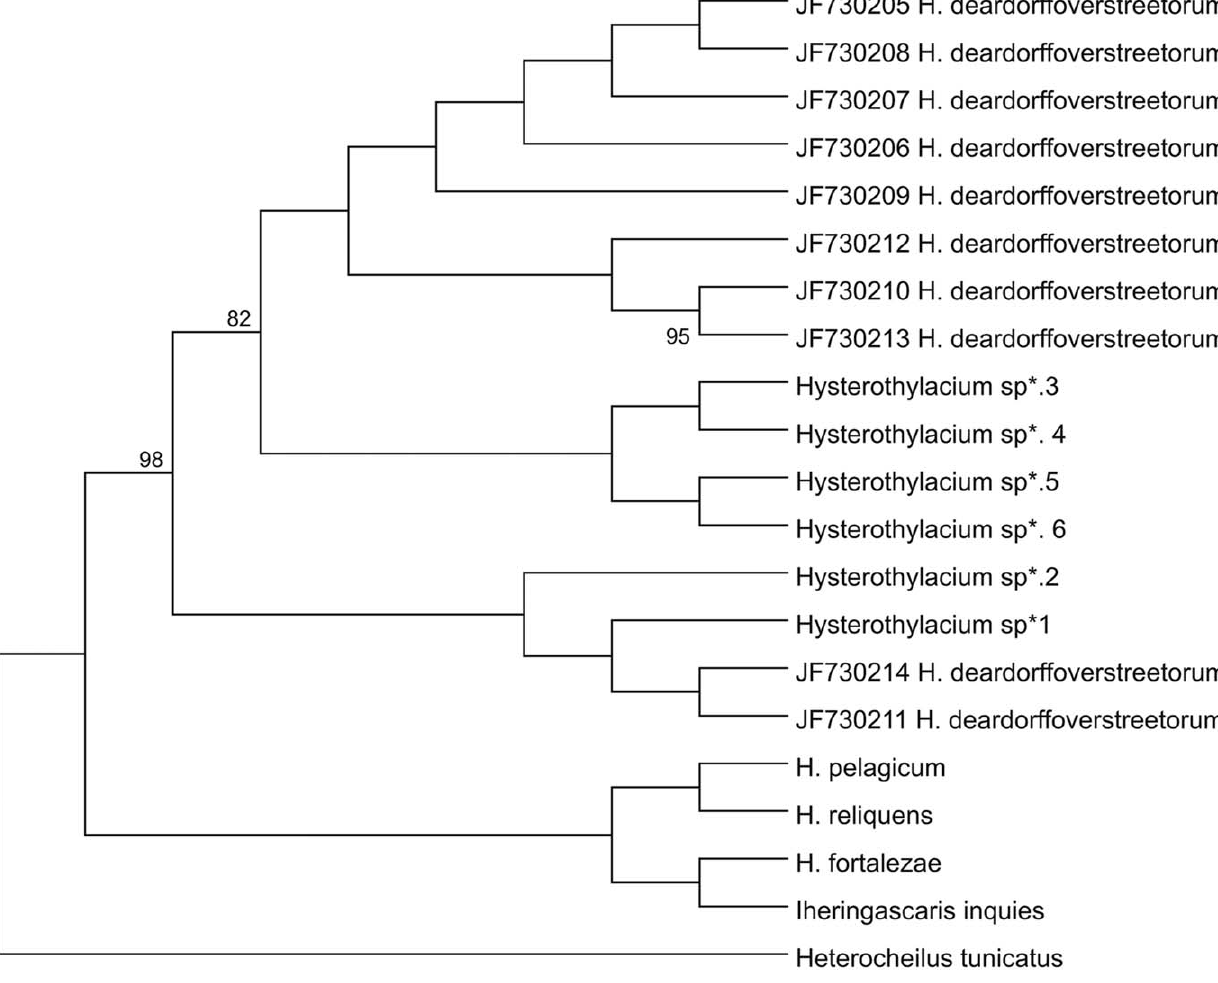
Figure 7. Maximum likelihood reconstruction between sequences of Hysterothylacium obtained in this study (*) and sequences of Hysterothylacium and Iheringascaris spp. from the GenBank, with the tree inferred from mtDNA cox -2 and LSU data sets. The numbers on the tree branches represent the percentage of bootstrap resampling. Heterocheilus tunicatus was used as an out group.